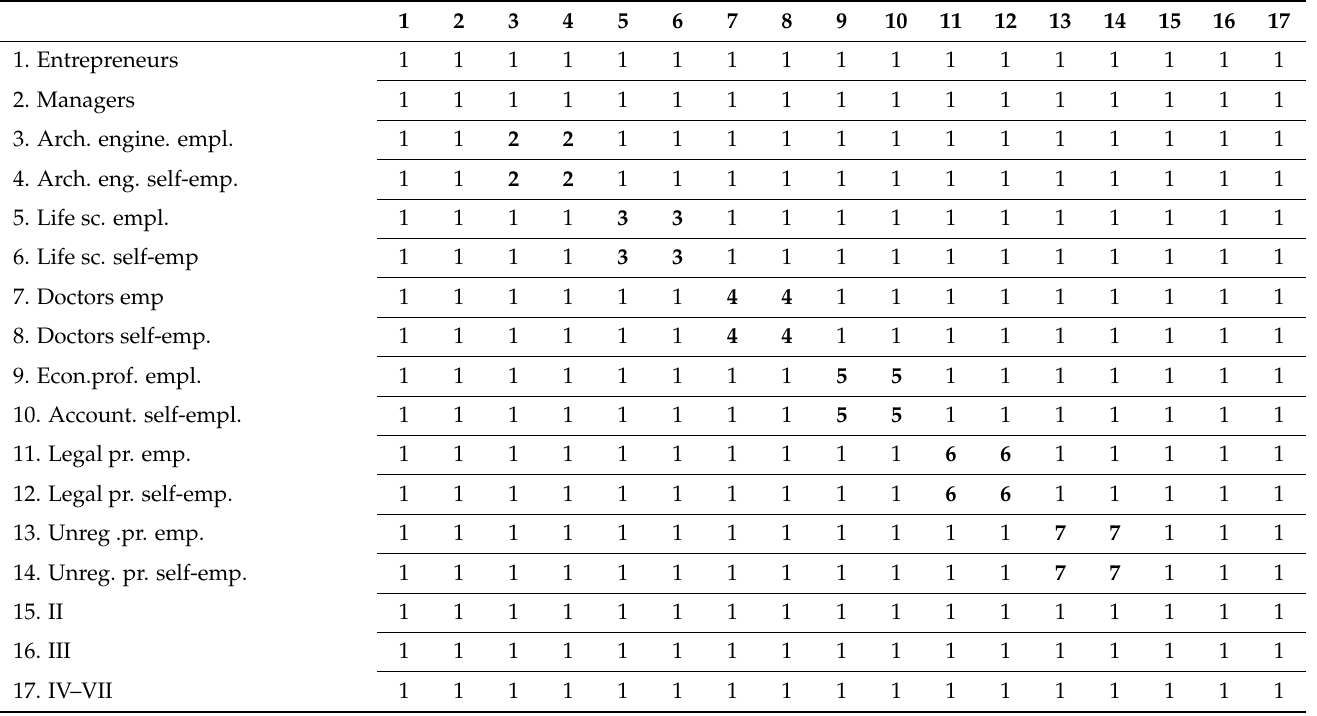
Table A3. Meso-class rigidities—Model 3a and